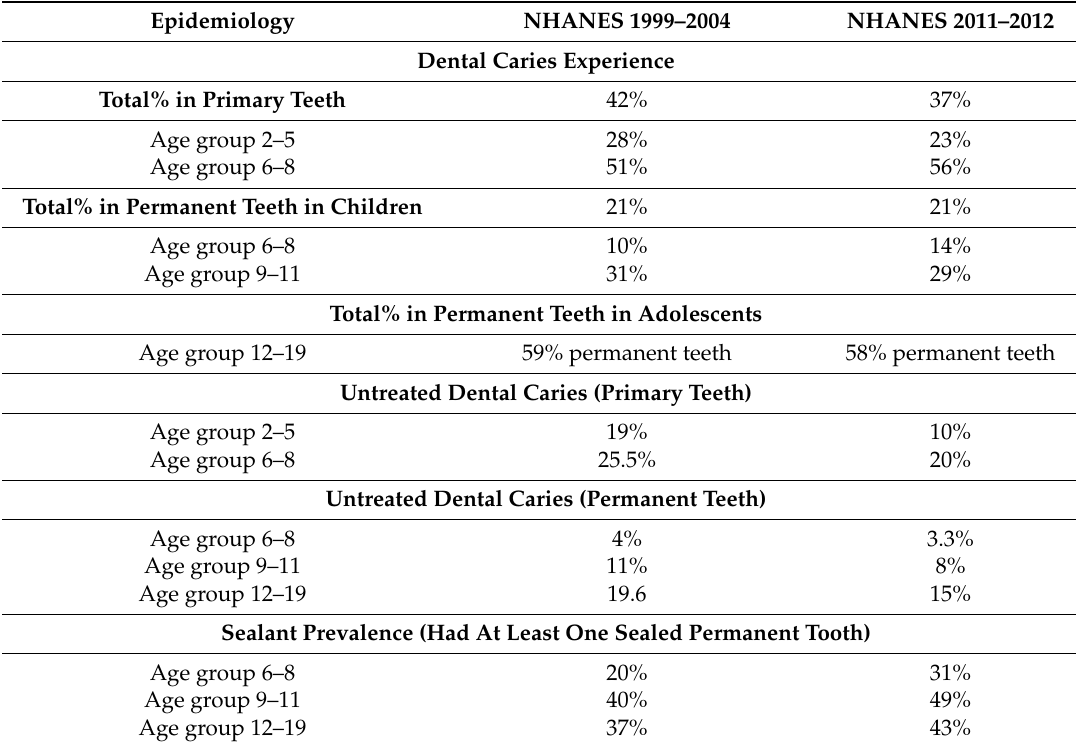
Table 1. Summary of data reported by NHANES 1 on the prevalence of caries and